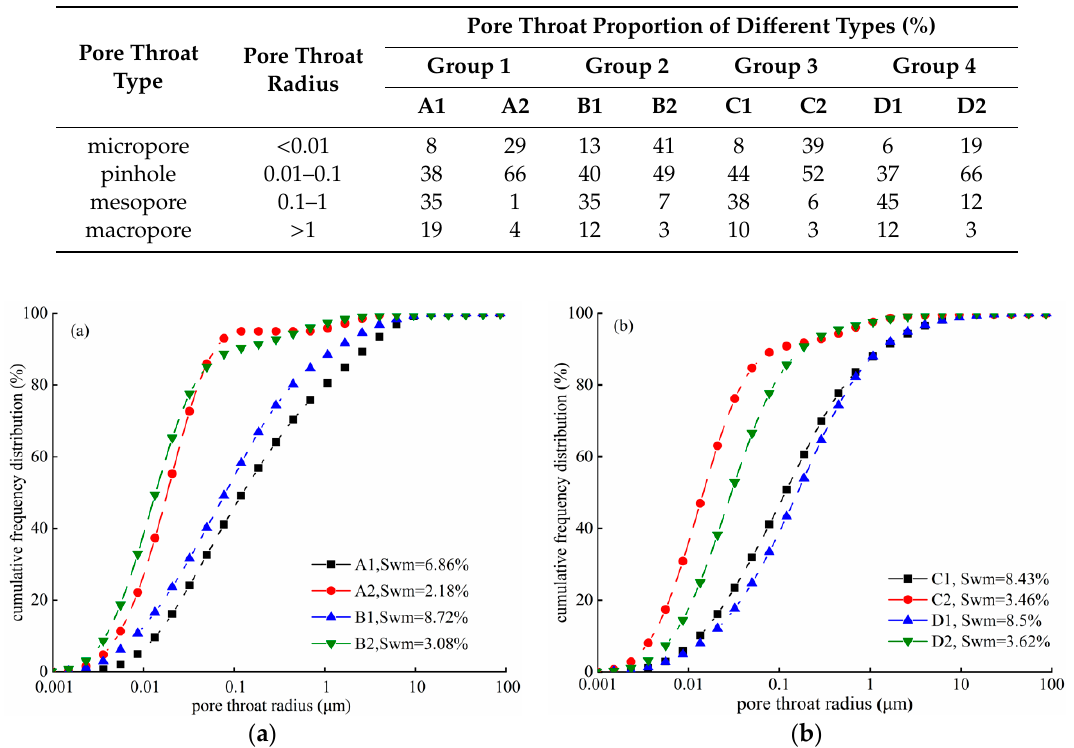
Table 2. Pore throat structure of tight sandstone cores.